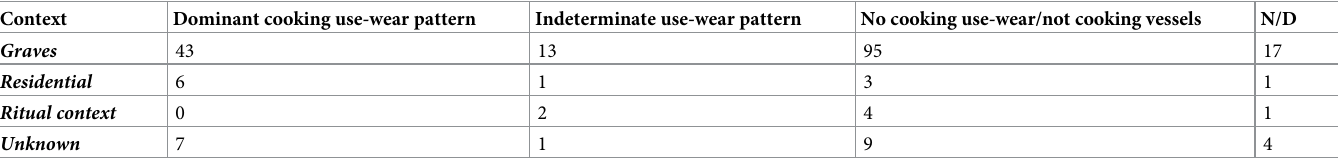
Table 1. Use-wear remains on Zhanqi